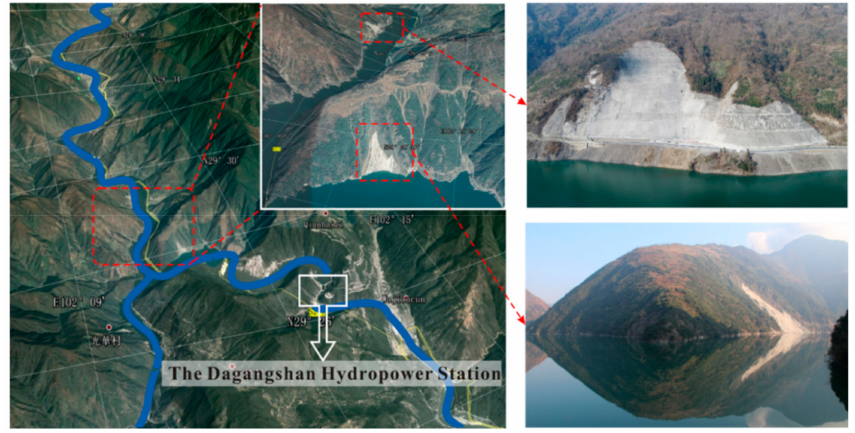
Figure 1. The complex river flows in the upper reaches of the reservoir: the Dagangshan Hydropower Station.